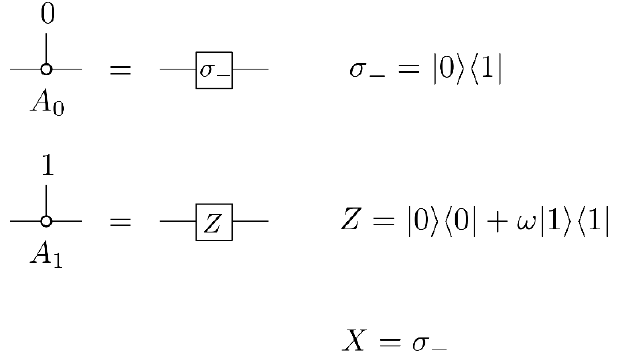
Figure 14 . An MPS description of the one-magnon state j (cid:9) i (cf.